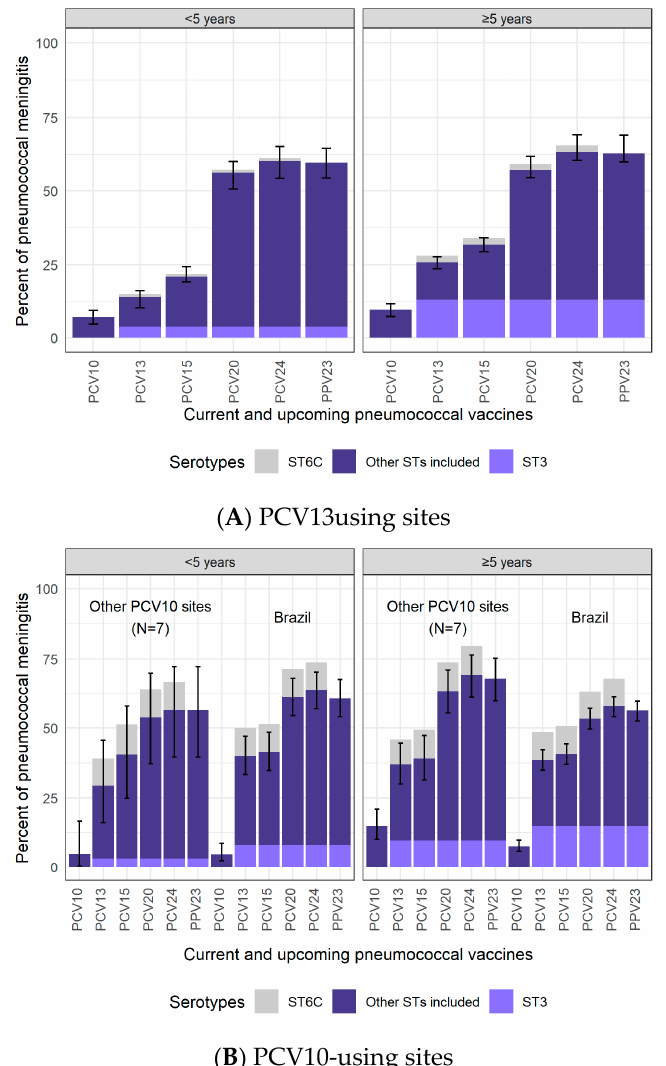
Figure 2. Percentage of CSF+ pneumococcal meningitis cases in the mature PCV10/13 period due to serotypes included in current and upcoming products. PCV13 is Pfizer’s Prevnar13/Prevenar13; PCV10 is GSK’s Synflorix. PCV13 results are modeled output. PCV10 results are a pooled distribution of 210 cases in Brazil and 43 cases in other PCV10 sites for <5 years of age and of 707 cases in Brazil and 181 cases in other PCV10 sites for ≥ 5 years of age. ST3 is illustrated separately in lighter purple in the bars corresponding to products that include ST3 due to the uncertain effectiveness against ST3 in current products [21–23]. ST6C is illustrated in grey above the bars where ST6A is included. Although ST6C is not included in PCV10 or PCV13, PCV13 offers cross-protection through ST6A [24]. ST6A also benefits from cross-protection with ST6B, included in both PCV10 and PCV13. Therefore, ST6A causes a very small fraction of disease in both settings and age groups, and it is not shown. Confidence intervals do not include ST6C, as this serotype is not included in PCV10/13. The percentage of PCV13-type cases was greater in PCV10-using sites than in PCV13- using sites (29.3–40.0% vs. 14.1% for <5 years and 37.0–38.5% vs. 25.8% for ≥ 5 years). If from 6A [24], the difference in the proportion of PCV13-type increases even more. Differ- ences between PCV10- and PCV13-using sites persist for PCV15-type cases but diminish for PCV20-, PCV24-, and PPV23-type cases, which ranged from 54–69% across all age sites: n = 181), the percent PCV10-type cases was lower in Brazil (7.6%; 5.8–9.8%) than in